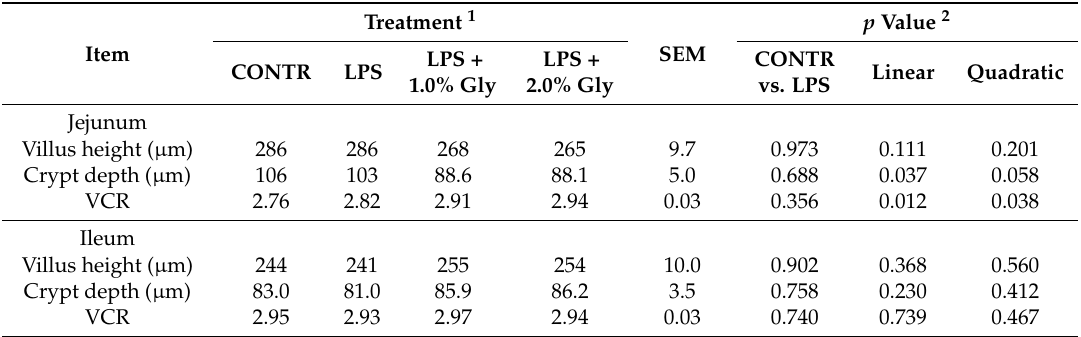
Table 1. Effect of glycine supplementation on intestinal morphology after 4 h lipopolysaccharide (LPS) challenge in piglets.